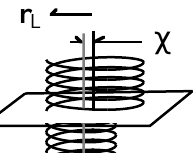
FIG. 18. The translation of the centroid of Larmor oscillations in an